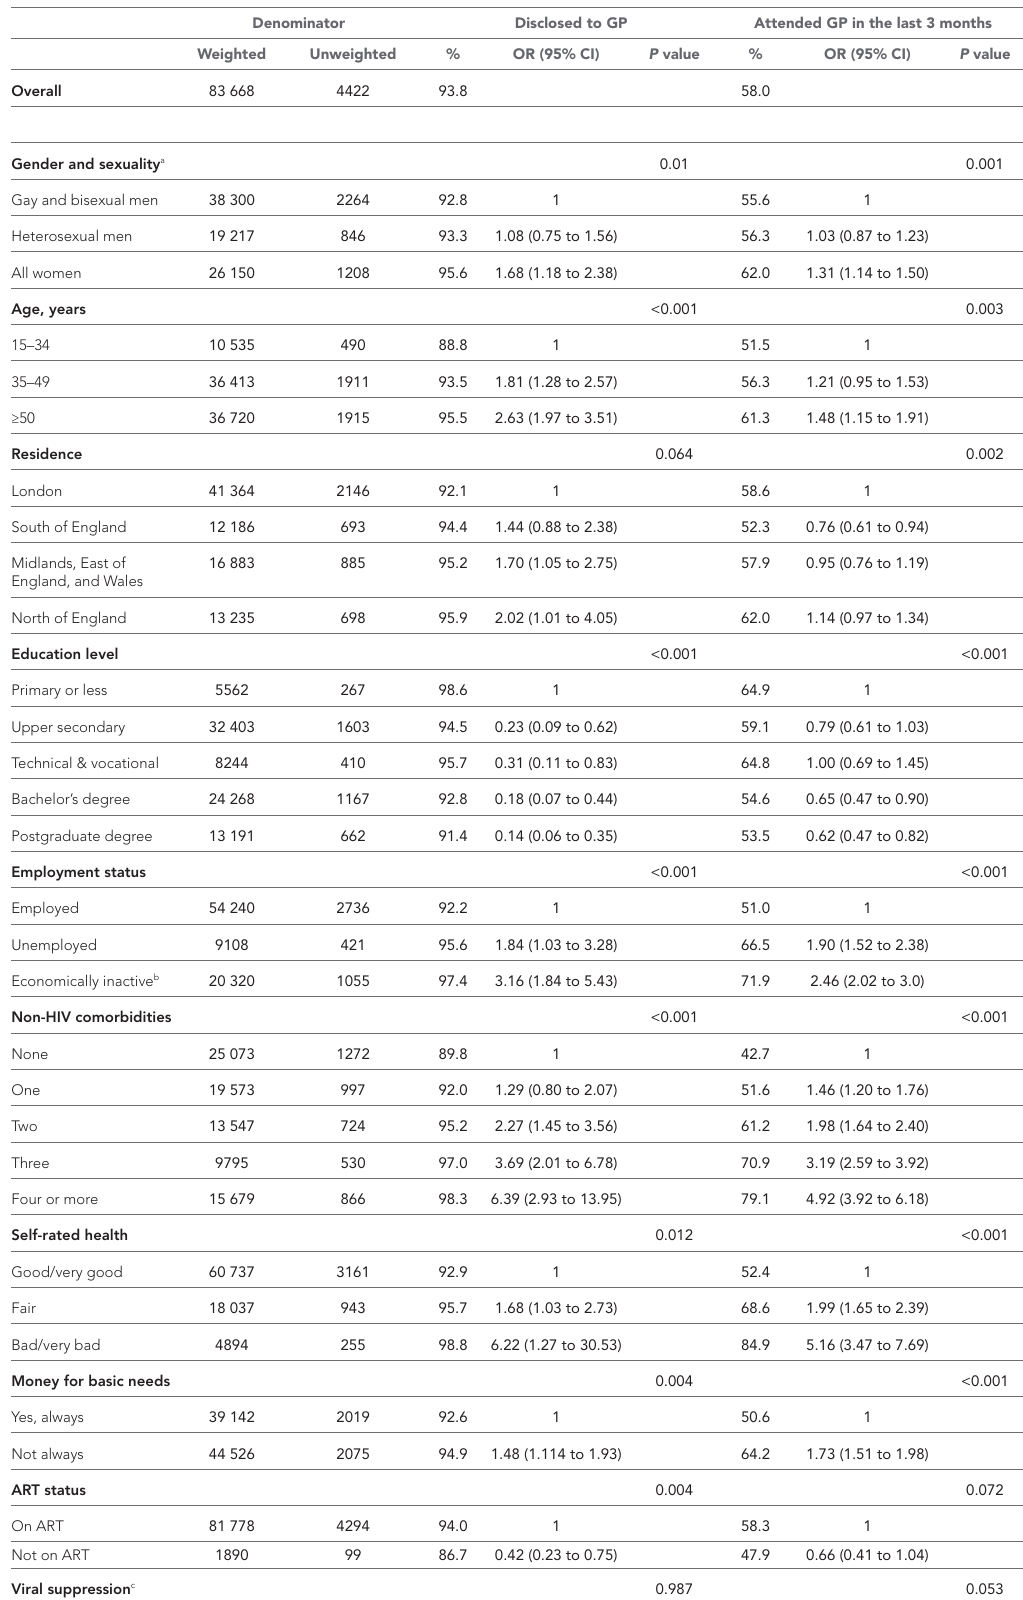
Table 1 Factors associated with GP disclosure and recent attendance among PLHIV registered